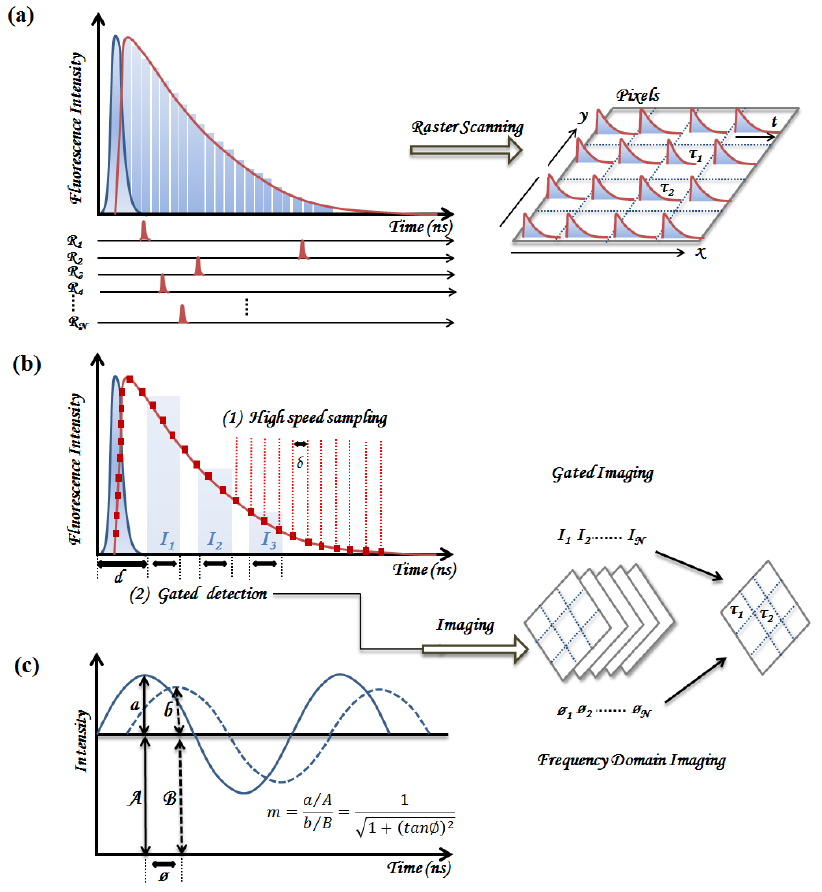
Figure 2. ( a ) The histogram built using TCSPC and the raster-scanning techniques used for fluorescence lifetime images. ( b ) Principles of high-speed sampling and time gated techniques. The fluorescence decay can be collected through different time gates ( I 1 to I 3 )